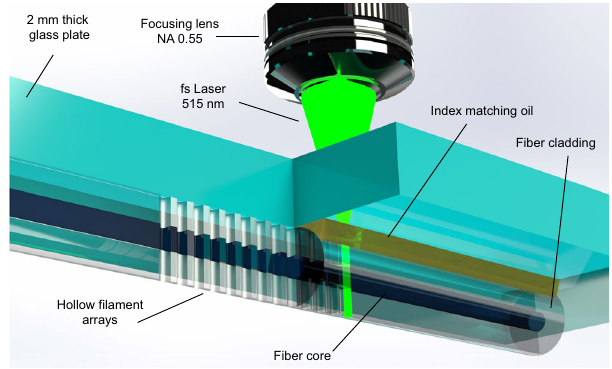
Fig. 1 Femtosecond laser fi lament processing in optical fi bre. Schematical arrangement of optical aberration plate and optical fi bre used for generating femtosecond laser fi laments, and opening high-aspect ratio nanoholes through the fi bre cladding and core